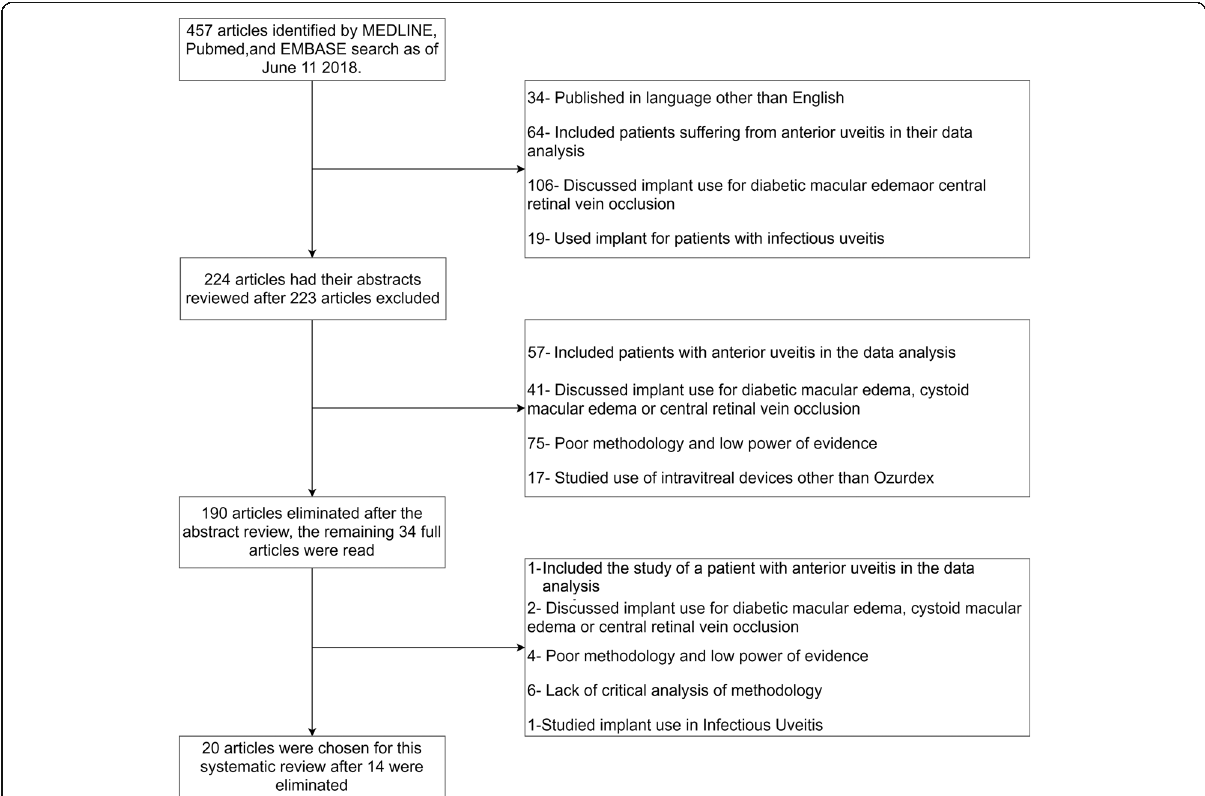
Fig. 1 The process of choosing the appropriate articles for this